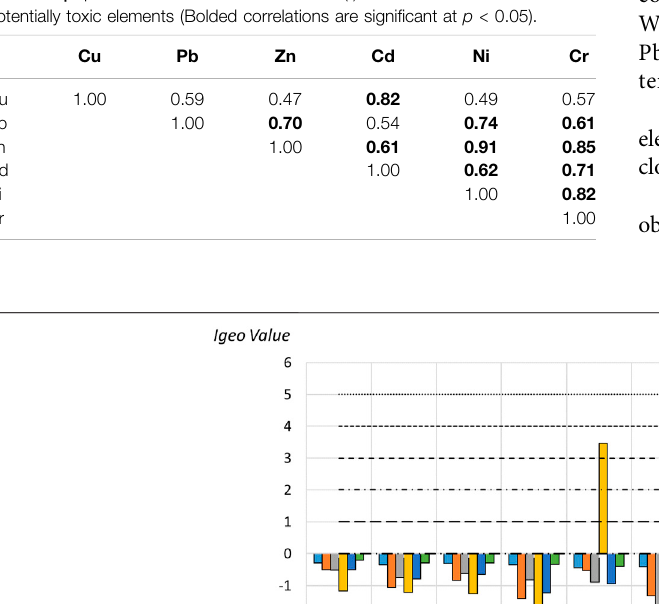
Frontiers in Environmental Science |